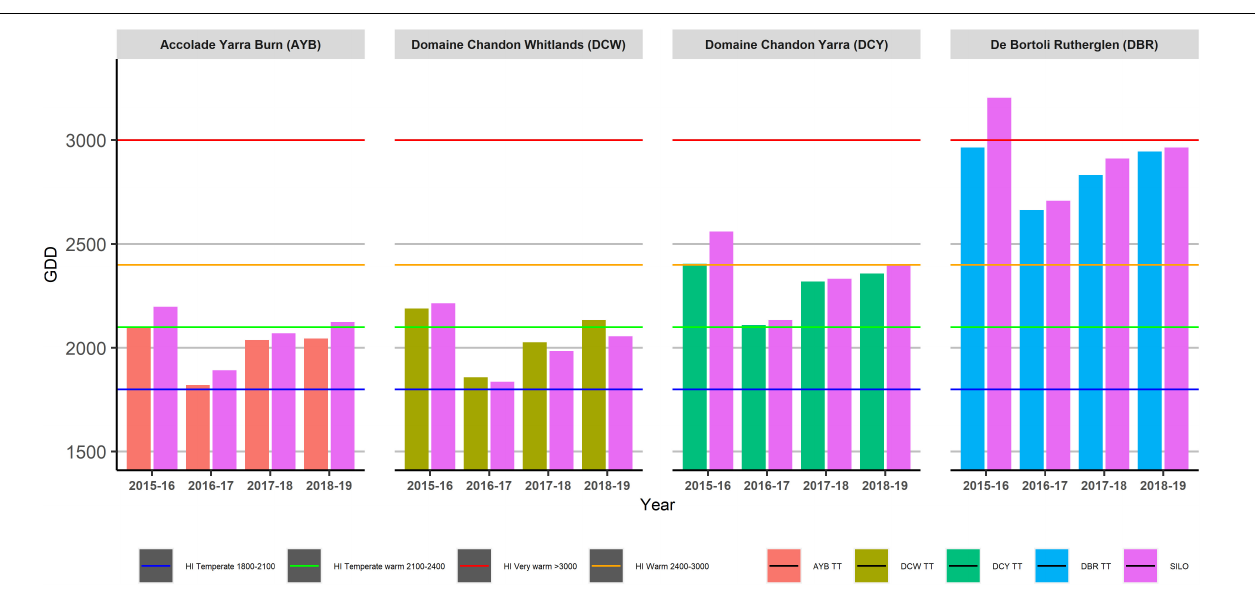
FIGURE 6 | Heliothermal index of Huglin (HI) across four sites and four seasons as calculated using Tinytag (TT) or Scientific Information for Landowners (SILO)